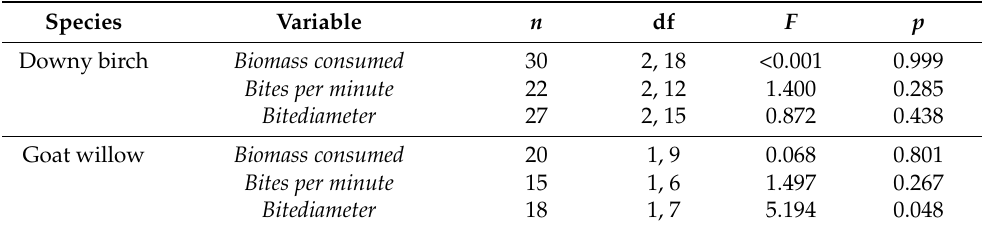
Table 2. Results from Mixed effects ANOVAS with treatment as explanatory variable and mountain hare individual as a random